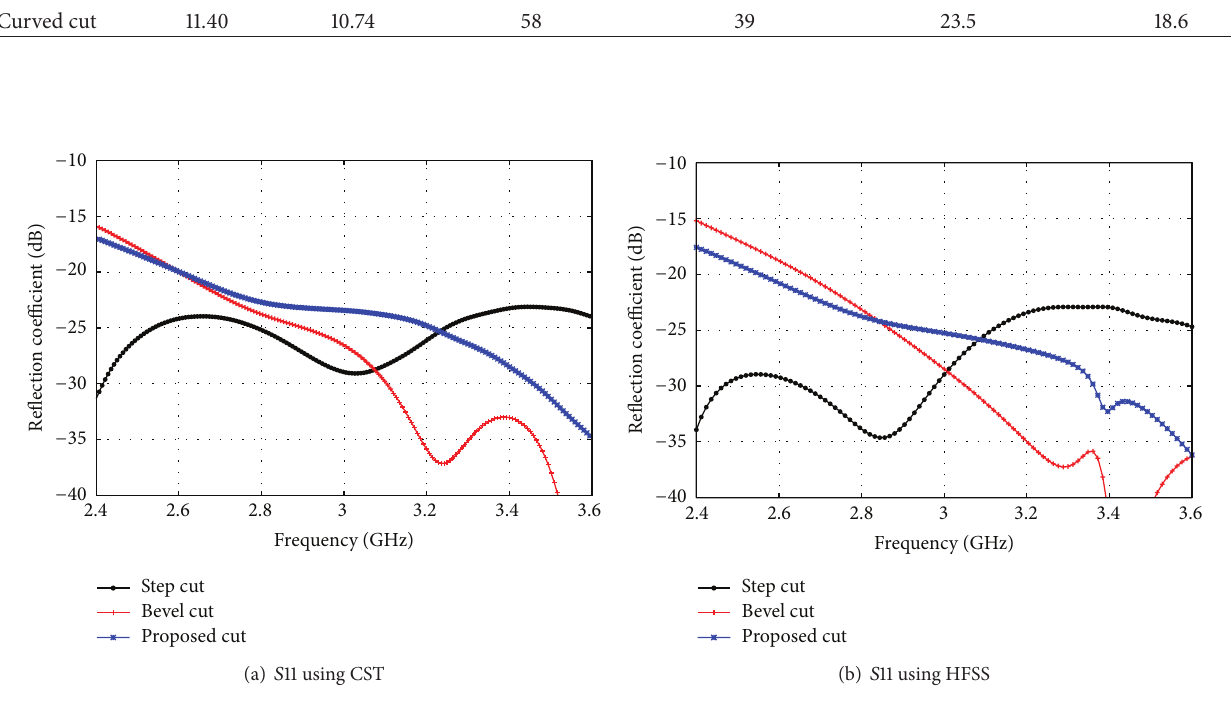
Figure 7: Comparison of the reflection coefficient, using both CST and HFSS.